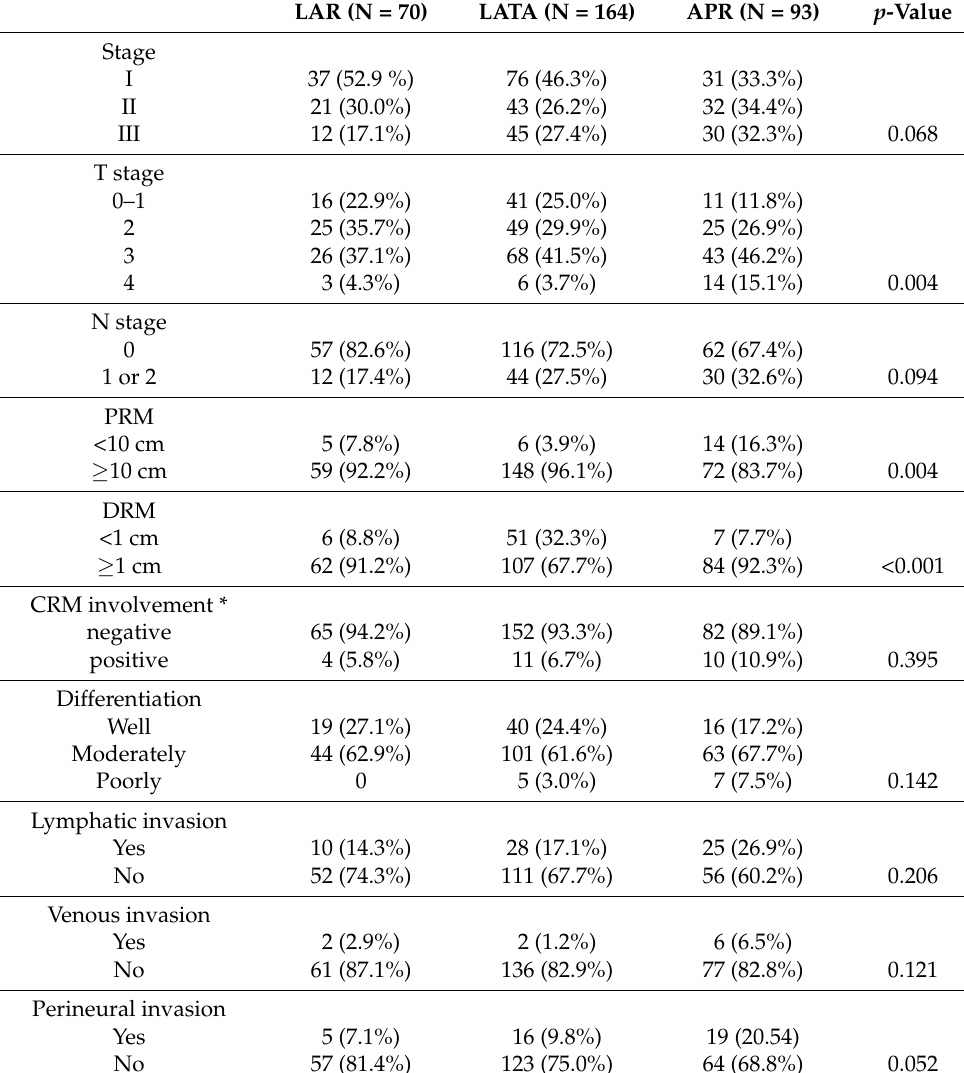
Table 4. Comparison of pathologic